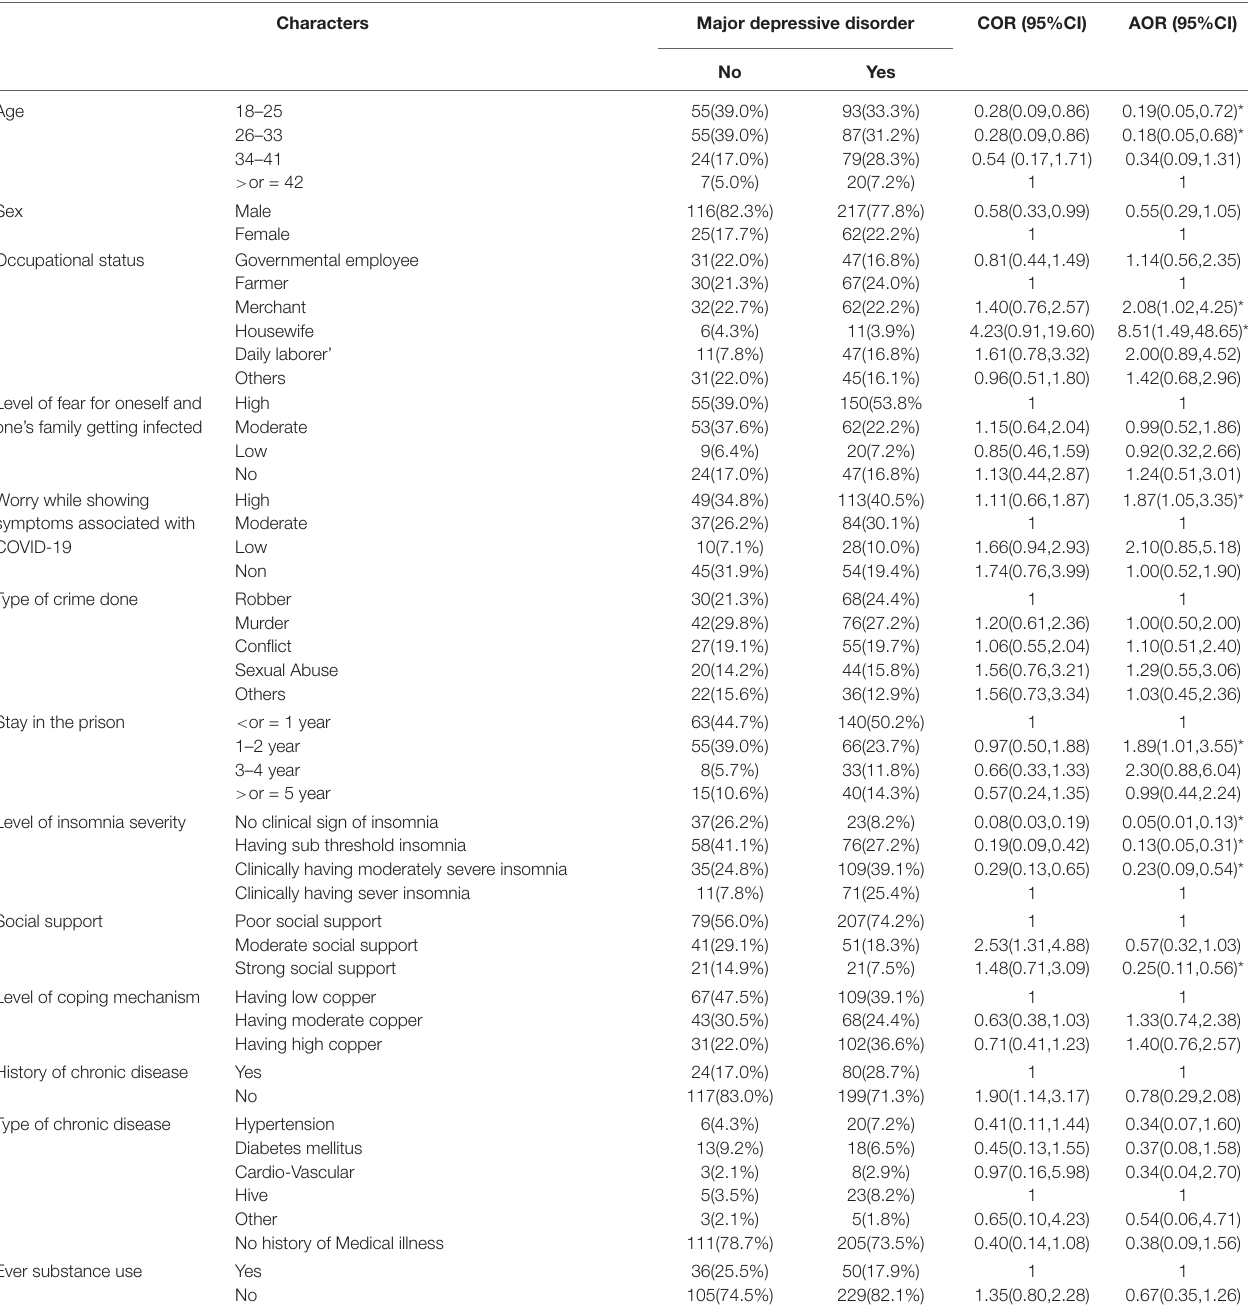
TABLE 6 | Multiple logistic regression: Factors associated with level of severity of insomnia, social support, copping mechanism, chronic disease, and substance use with generalized anxiety disorder during COVID-19 pandemic among Dessie town prisoners, in Dessie Amhara region, Northeast Ethiopia, October 2020; ( n = 420).